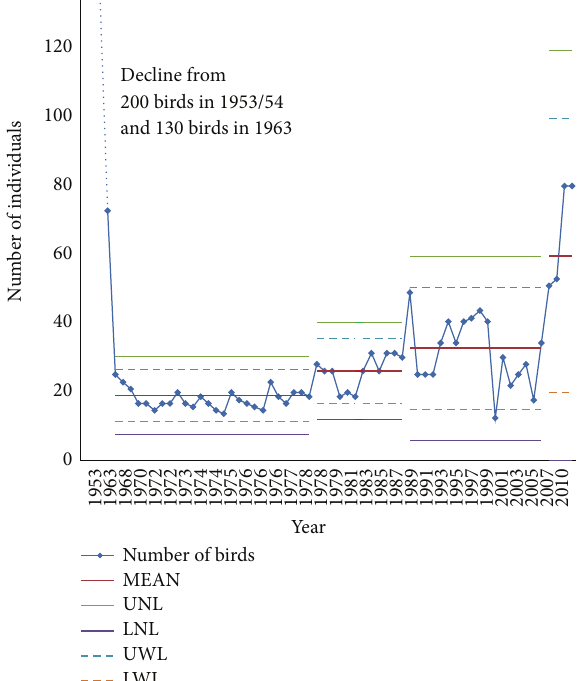
Figure 2: Population counts of wild Puerto Rican parrots showing natural limits and warning limits (data from [19–21]).